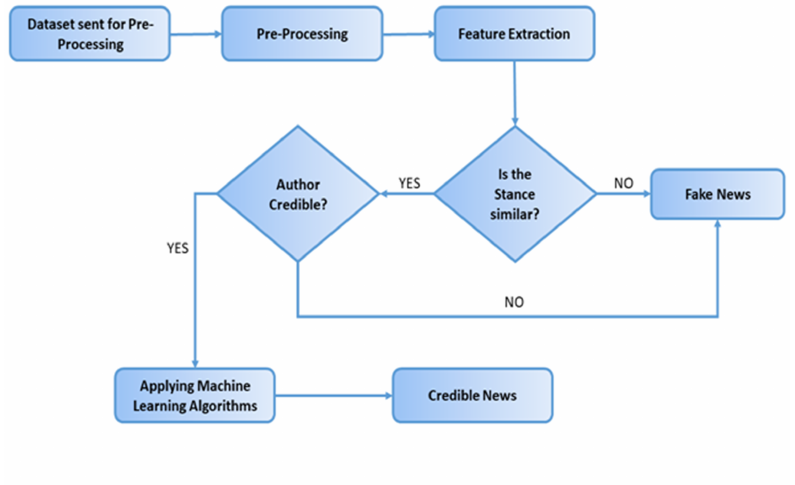
Figure 5. Flow diagram of the